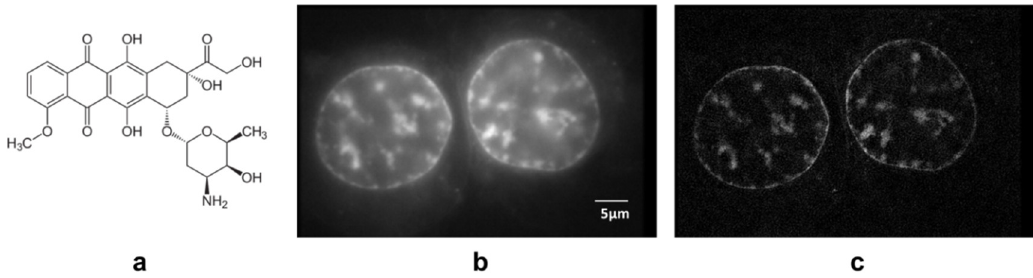
Figure 5. Molecular structure of doxorubicin ( a ); fluorescence images of MCF-7 breast cancer cells incubated with doxorubicin (4 µM, 24 h) using wide-field microscopy ( b ), SIM ( c ); excitation wavelength: λ 0 = 488 nm; detection range: λ D ≥ 515 nm; Plan Neofluar 40×/1.30 oil immersion objective lens .